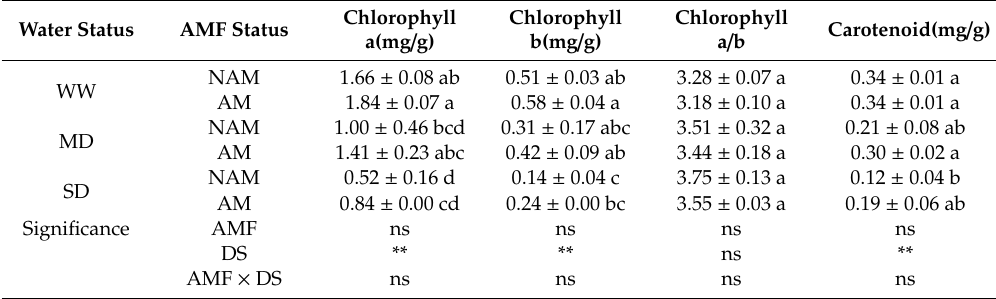
AMF × DS ns Table 3. E ff ect of the arbuscular mycorrhizal fungus (AMF) Rhizophagus intraradices on photosynthetic pigment concentrations in Catalpa bungei seedlings under DS. Chlorophyll Chlorophyll Chlorophyll Carotenoid(mg / g) Water Status AMF Status a(mg / g) b(mg / g) a / b